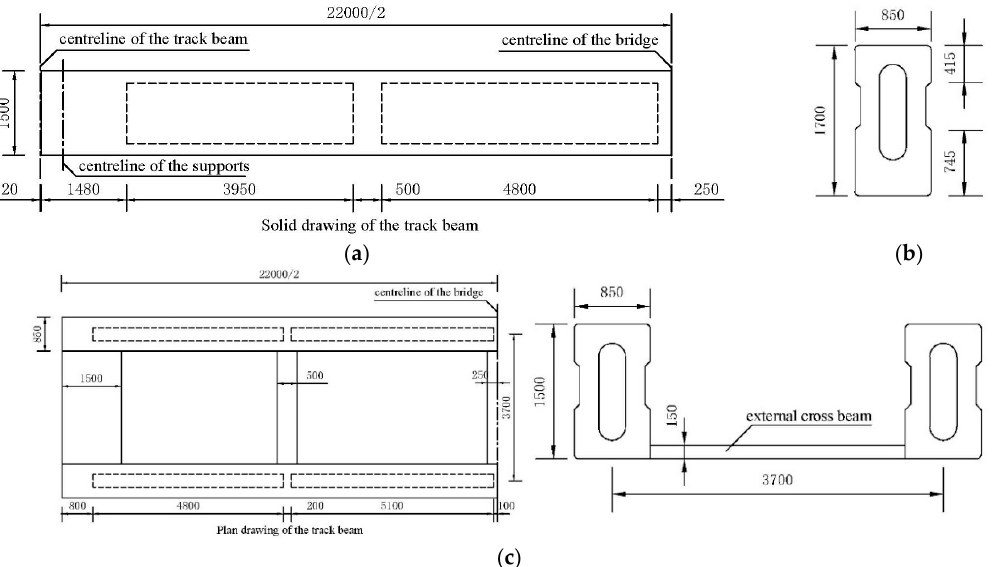
Figure 13. Improvement measures for the bridge—( a ) increasing the thickness of the inner cross ‐ beams (mm), ( b ) increasing the beam height (mm), and ( c ) setting external cross ‐ beams (mm).